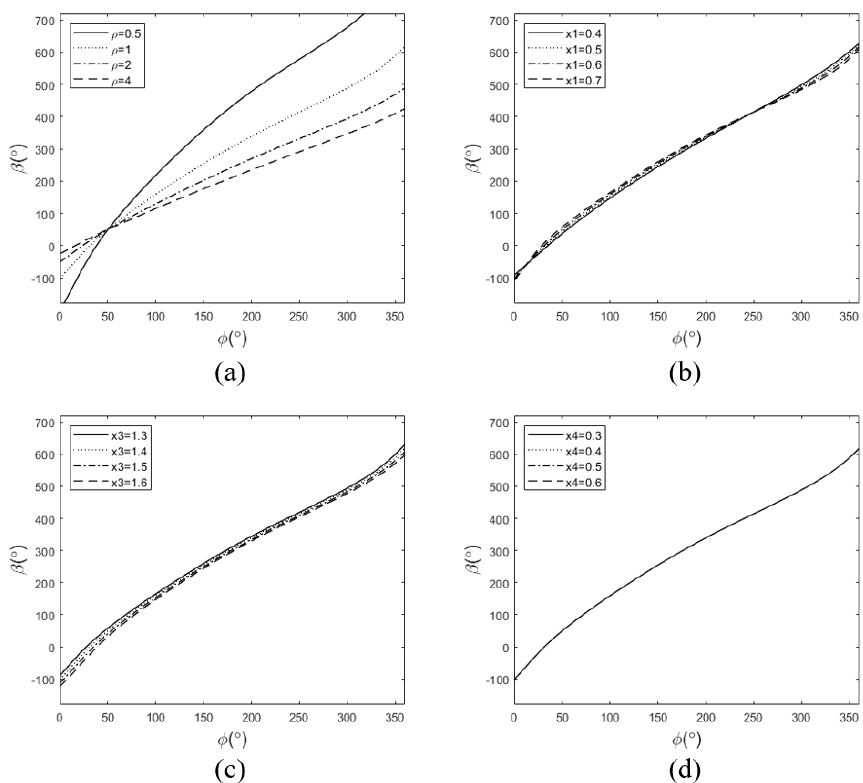
Figure 11. The effect of parameters on rotation angle of the guidance link. (a) ρ . (b) x 1 . (c) x 3 . (d) x 4 .